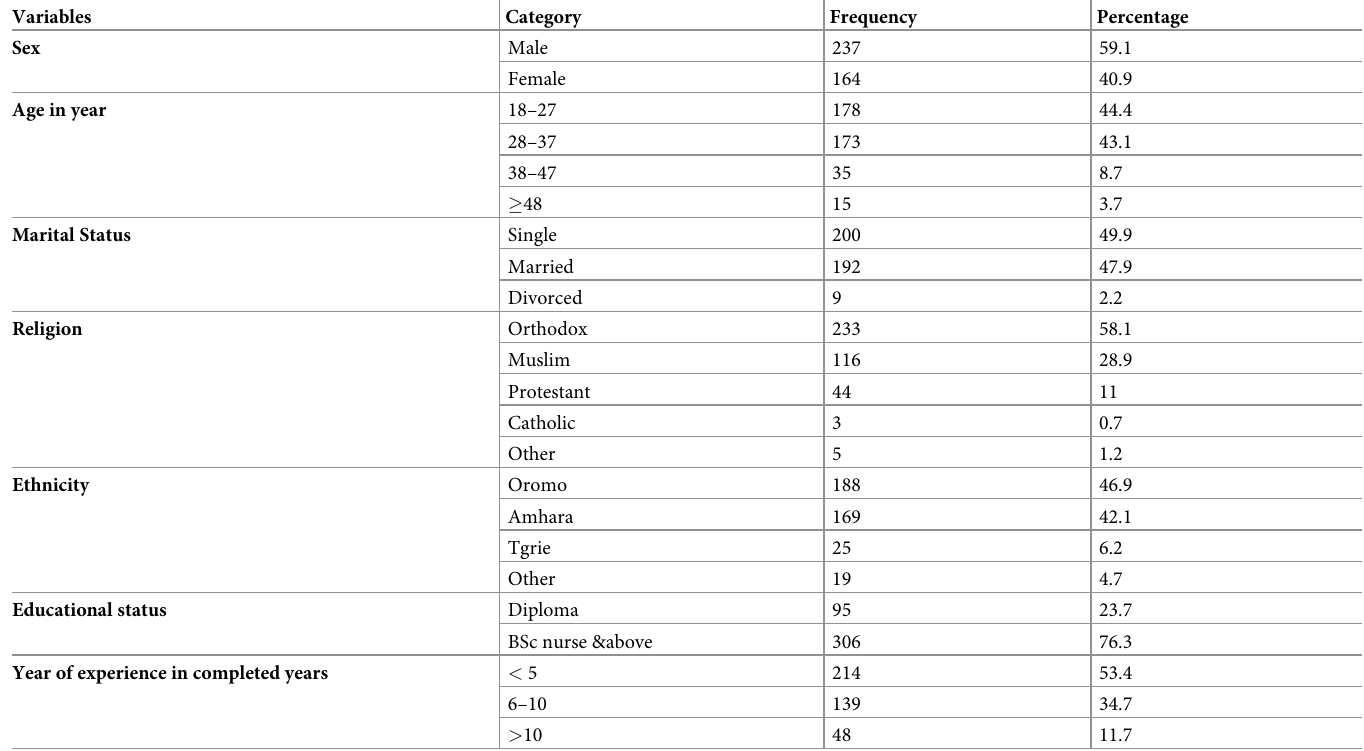
Table 1. Socio-demographic characteristics of nurses working in government hospitals of Harari regional state and Dire Dawa city administration, Eastern Ethio- pia, 2018 (n = 401). Variables Category Frequency